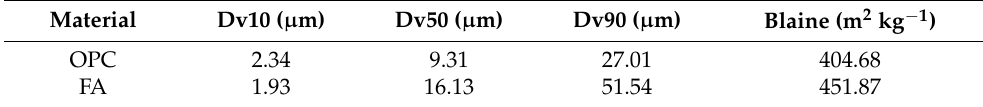
Table 3. OPC and FA particle size distribution and Blaine specific